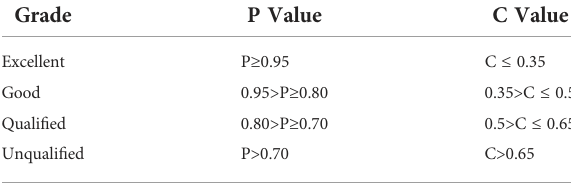
TABLE 2 Standard of accuracy of posterior error test about GM (1,1) grey